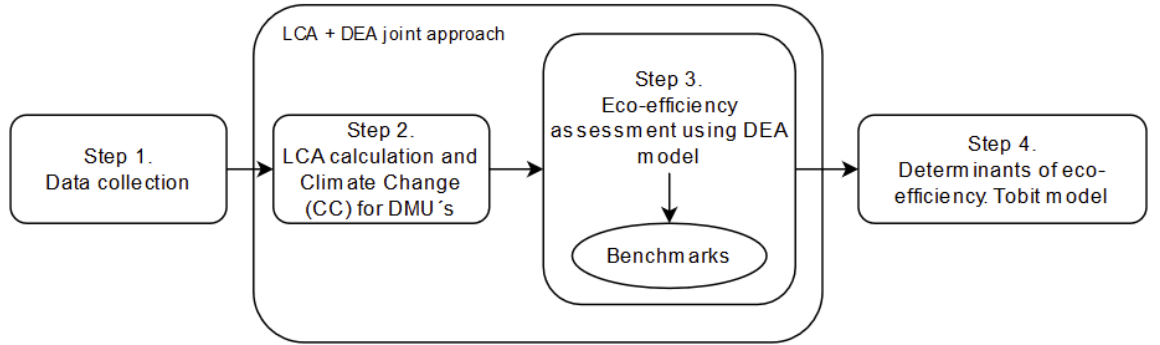
Figure 2. Four-step LCA–DEA and Tobit model (adapted by Rebolledo-Leiva et al. [34] and Angulo- Meza et al. [35]). Life Cycle Assessment (LCA), Data Envelopment Analysis (DEA).